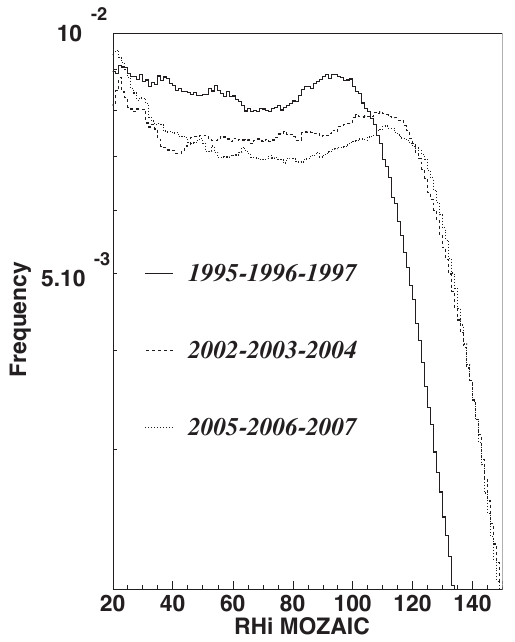
Fig. 5. Distributions of relative humidity seen by MOZAIC RHi M for the years 1995-1996-1997 compared to distributions for 2002- 2003-2004 and 2005-2006-2007. for further overpasses of a region, which is very sparse for accurate statistics. 352 grid boxes have an average time step smaller than 10 days but 273 grid boxes have an average time step larger than 10 days, 67 grid boxes attain average delays larger than 100